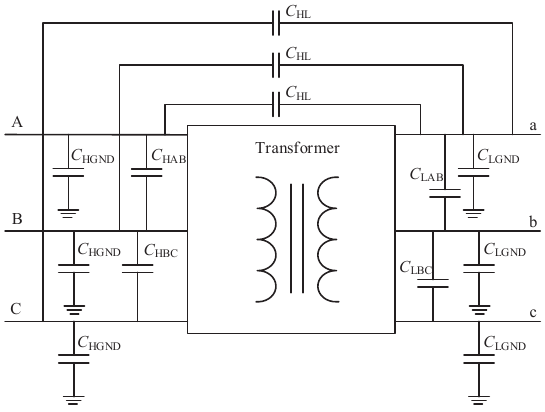
Figure 5. High frequency (HF) model of step-up transformer with terminal stray capacitances.